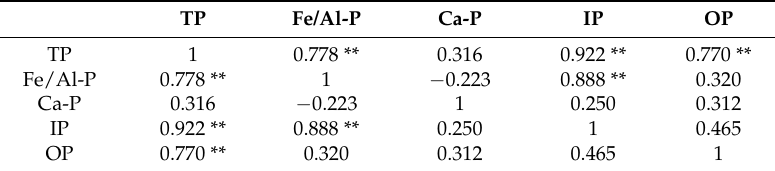
Figure 4. Distributions of P fractions in sediments. Table 2. Results of Pearson correlation analysis ( n = 12).